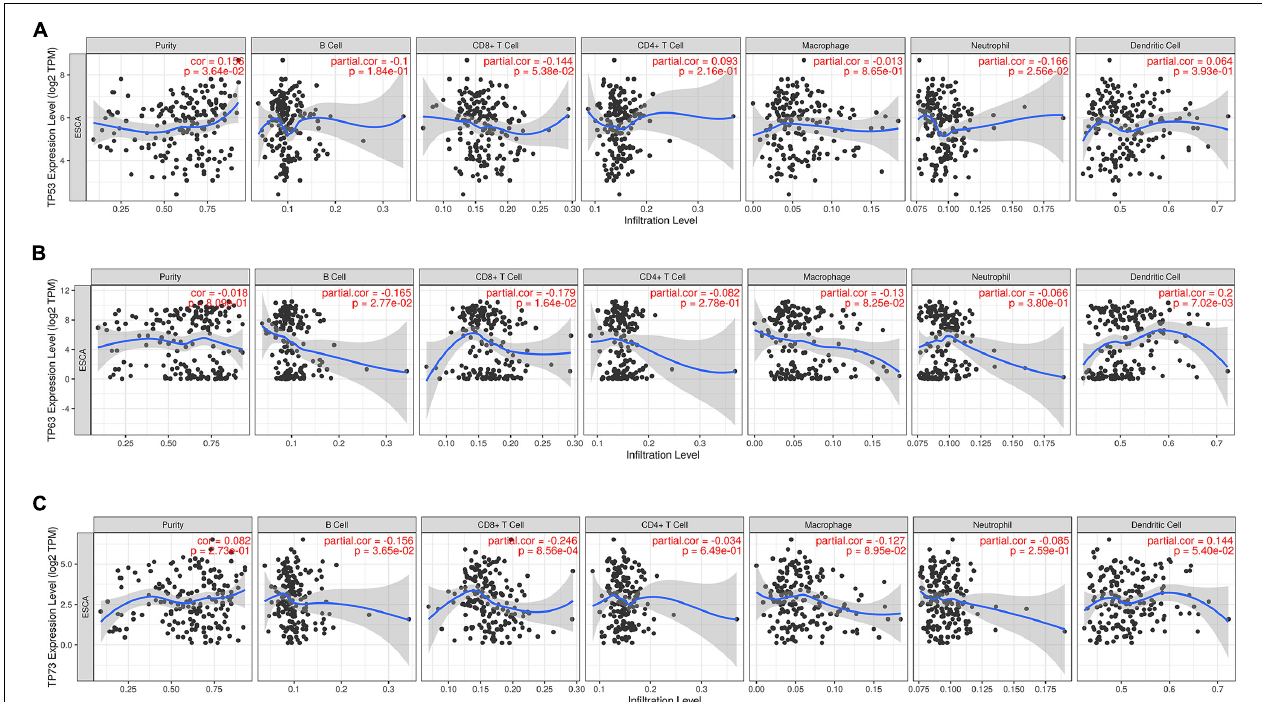
FIGURE 3 | The correlation between TP53 family members and immune infiltration cells. The expression level of TP53 family members was associated with immune cell infiltration (A–C) .